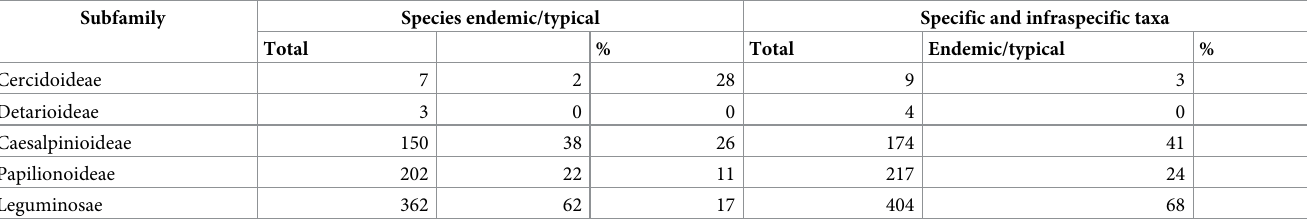
Table 6. Summary of endemic/typical Leguminosae taxa from Chaco ecoregion.